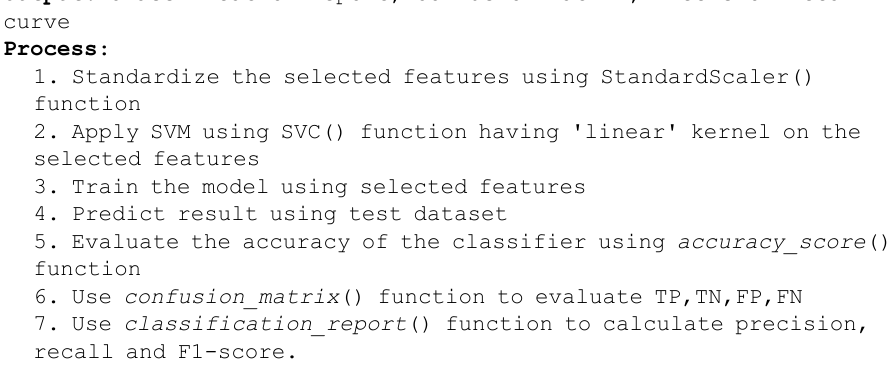
Algorithm 2. Abnormality detection using